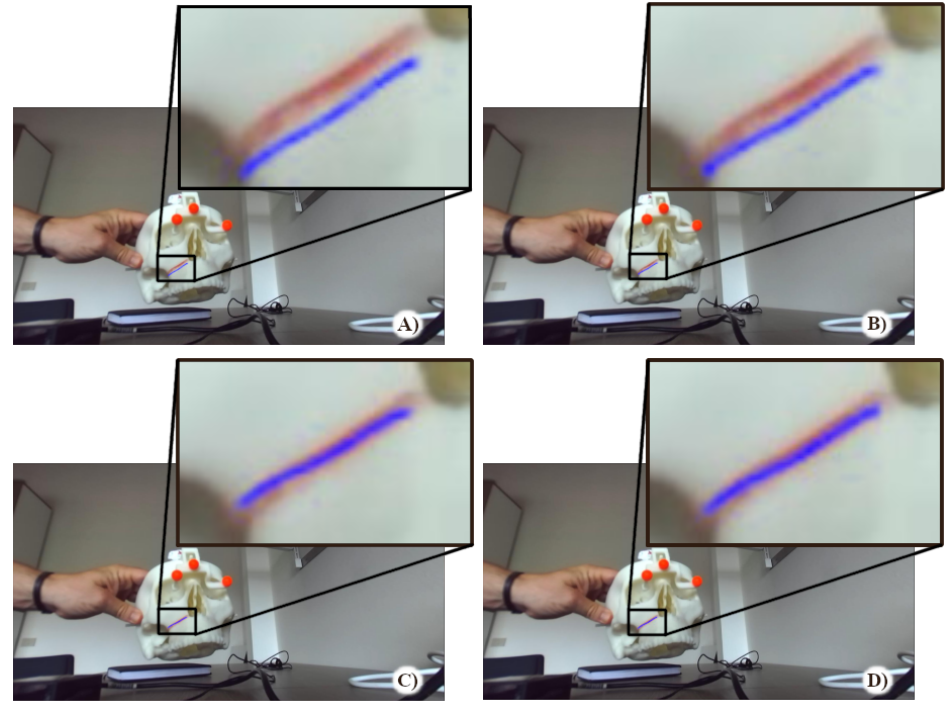
Figure 10. Augmented frames associated to the four tracking modalities:( A ) Optical tracking without refinement; ( B ) Optical tracking with refinement; ( C ) Heterogeneous tracking without refinement; ( D ) Heterogeneous tracking with refinement.